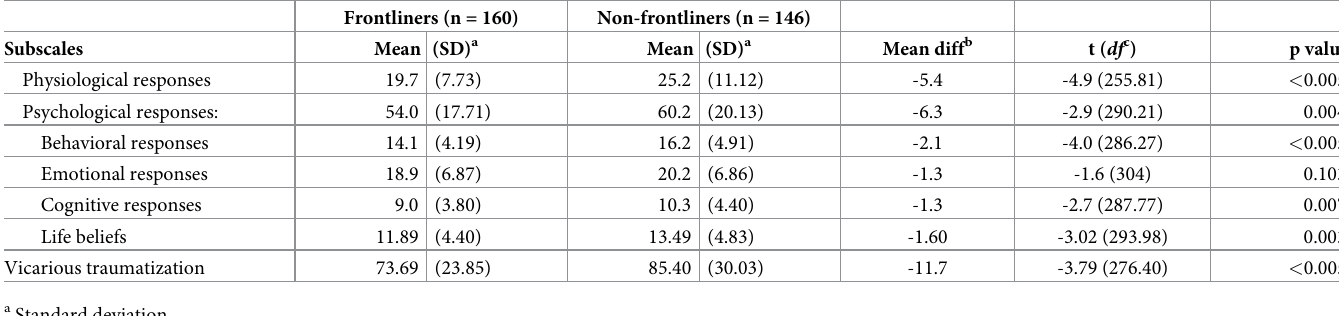
Table 3. Vicarious Traumatization Questionnaire subscales.